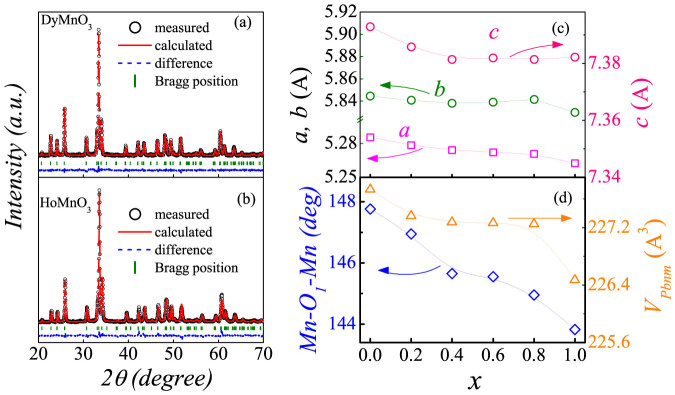
The evaluated structural information of a series of samples Dy1−xHoxMnO3 (0 ≤ x ≤ 1).The XRD patterns and Rietveld refined spectra for (a) DyMnO3 and (b) HoMnO3 samples, respectively. (c) The obtained lattice parameters of a, b, and c as a function of x. (d) The evaluated lattice volume V and Mn-O1-Mn bond angle as a function of x.